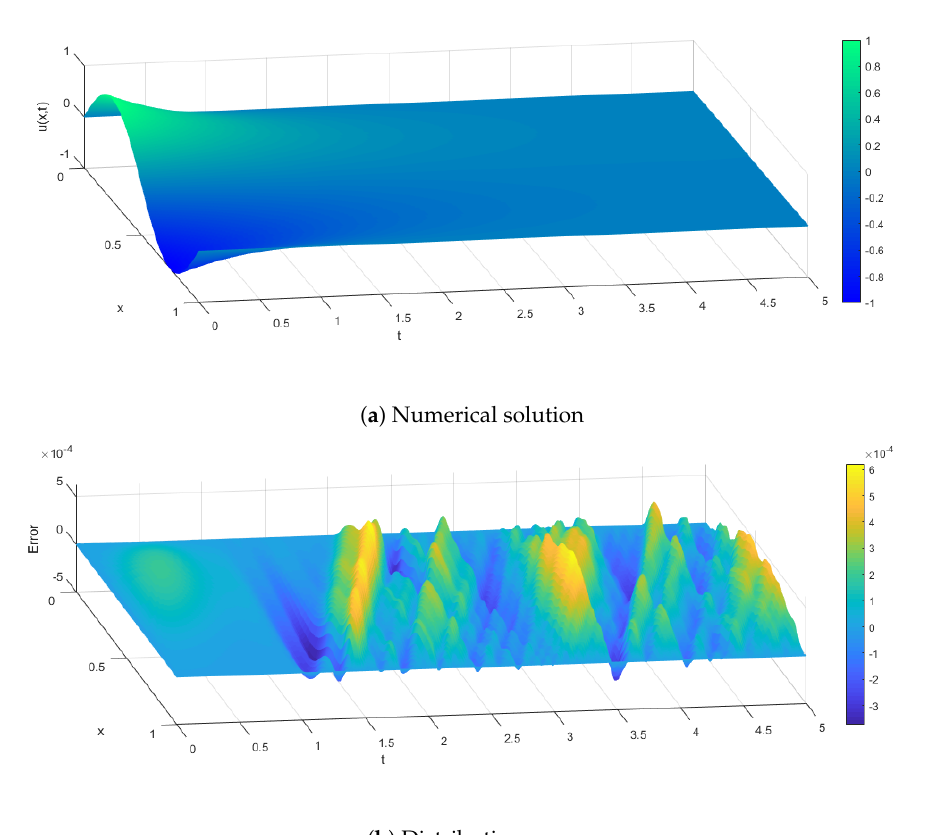
Figure 6. Numerical solution and distribution error with ∆ x = 0.0005 and ∆ t = 1/40 and T = 0 to 5. Example 2. The single solitary wave: the BBM-KdV